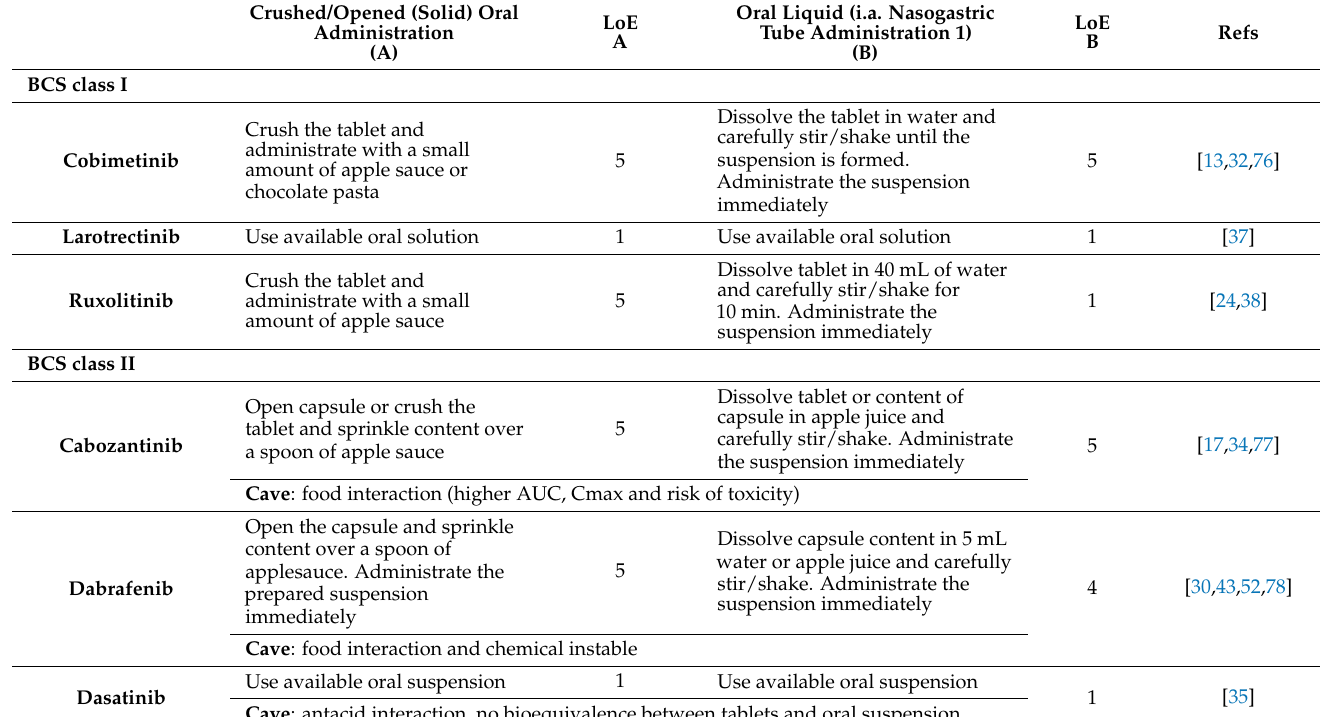
Table 1. Practical recommendations for the manipulation of a KI